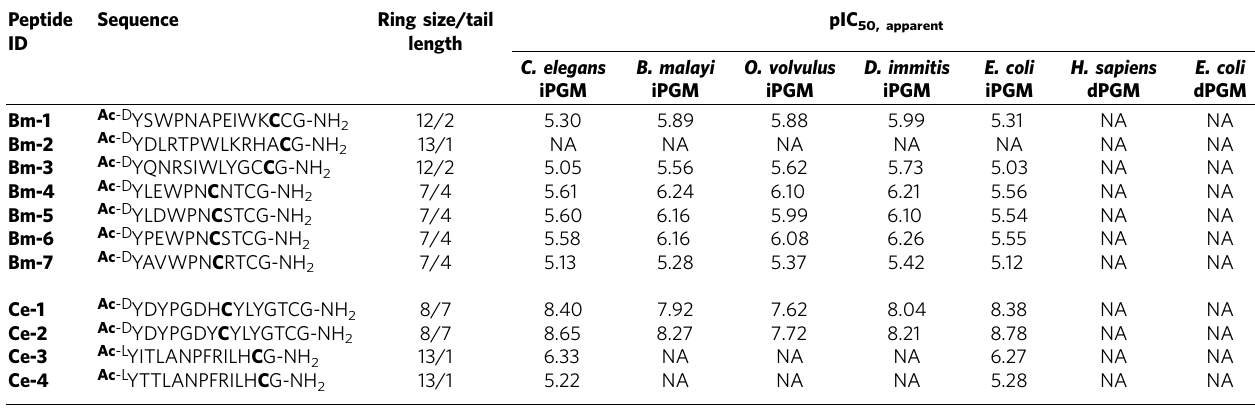
Table 1 | PGM panel inhibitory activity of RaPID selected, chemically resynthesized peptides. Peptide ID